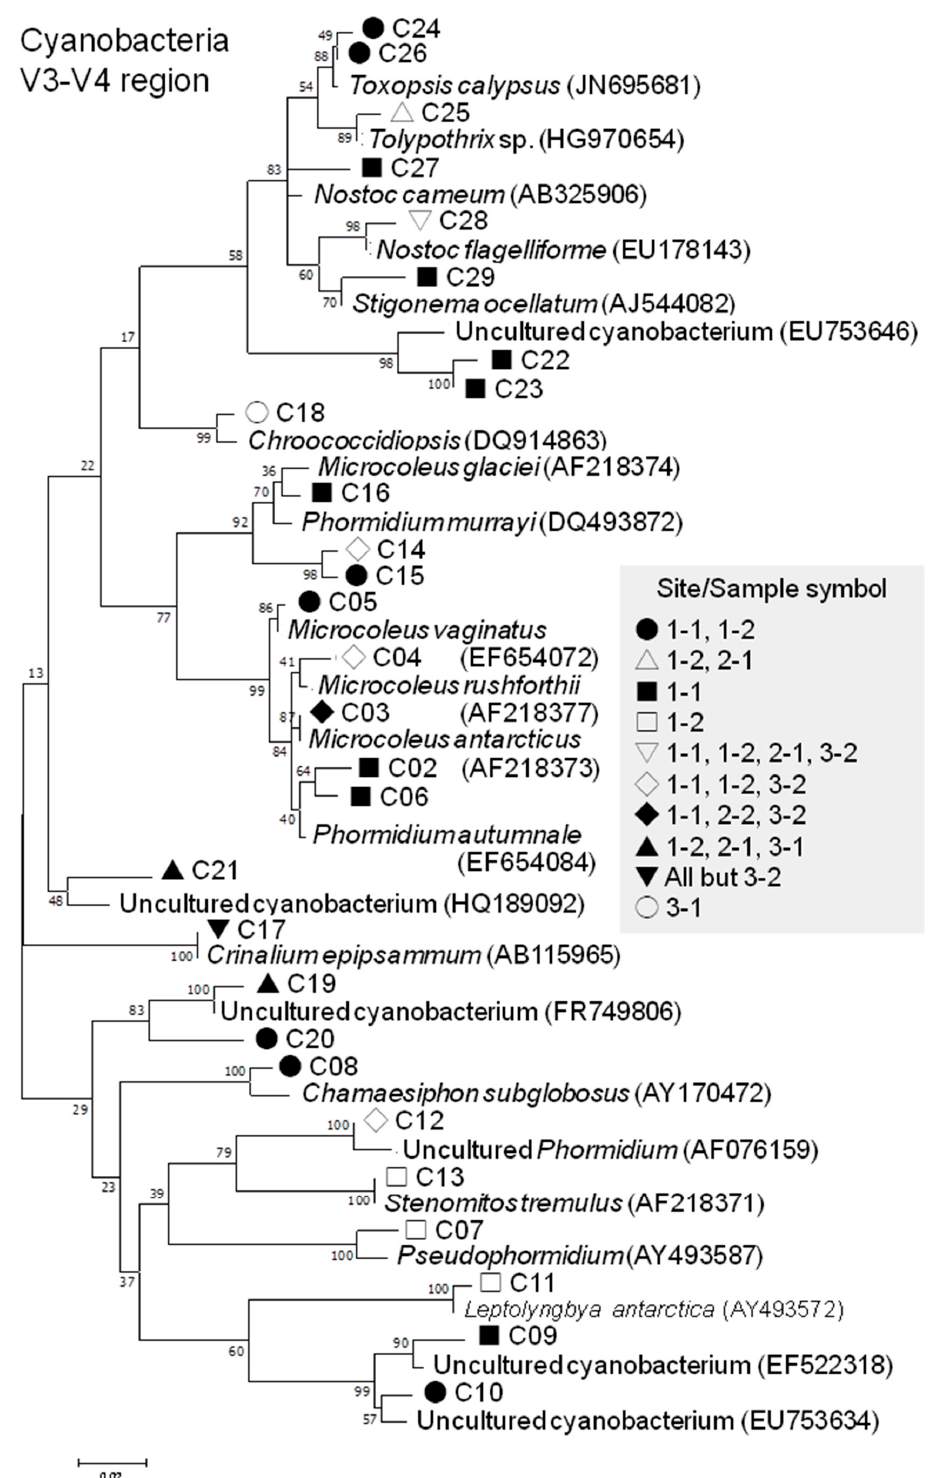
Figure 6. Phylogenetic trees of V3-V4 regions of 16S rRNA gene of the lichen-associated cyanobacterial phylotypes (with accession numbers) generated by the Maximum Composite Likelihood method. The tree with the highest log likelihoods ( − 3441.61) is shown. The percentage of trees in which the associated taxa clustered together is shown next to the branches. The tree is drawn to scale, with branch lengths measured in the number of substitutions per site. Phylotype codes correspond to those shown in Table